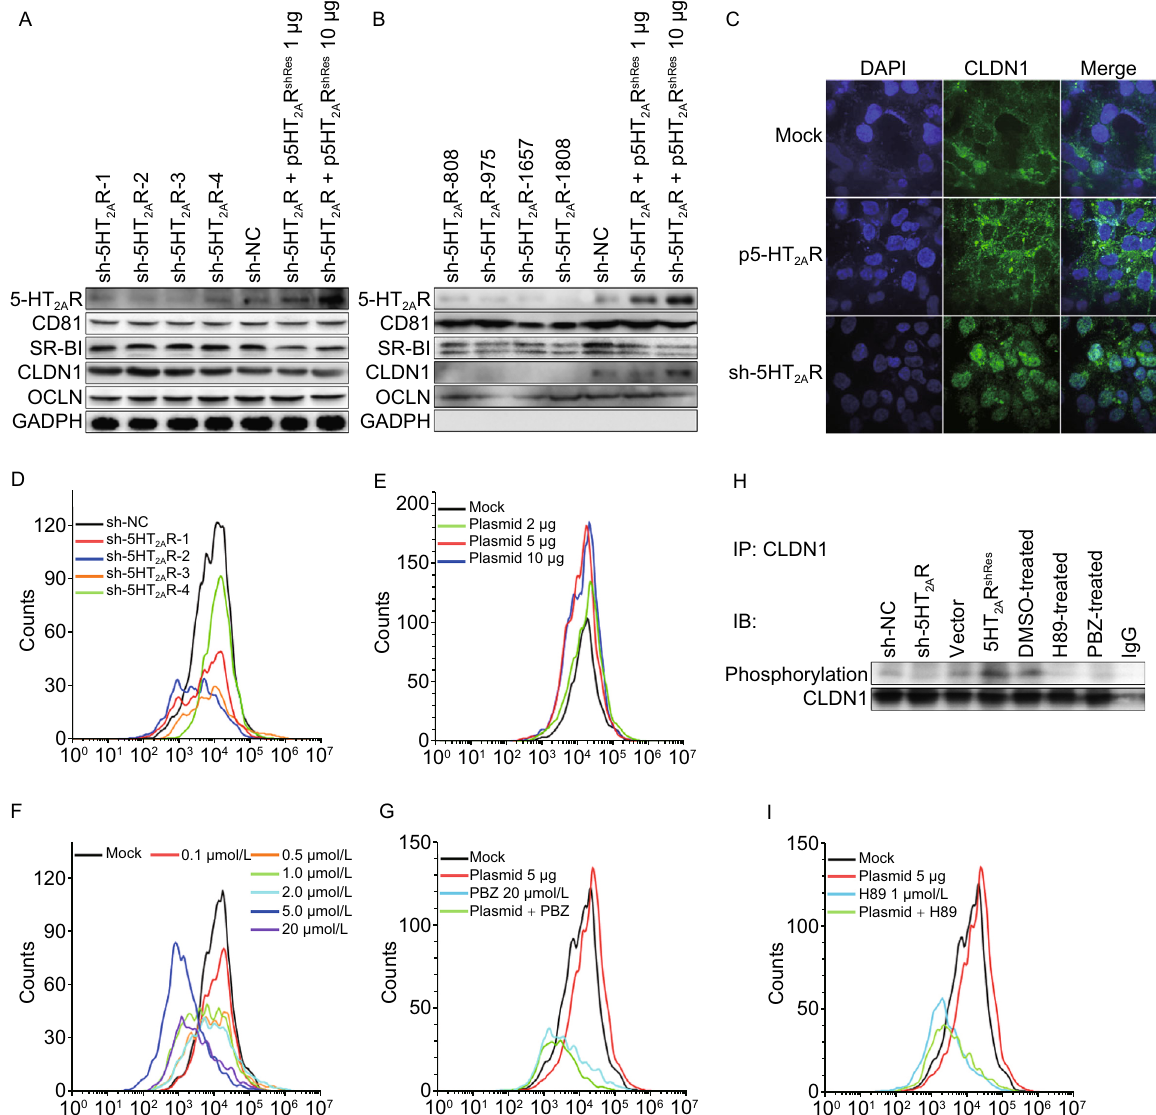
Figure 4. 5-HT 2A R plays a role in the membrane distribution of CLDN1. (A) The expression of 5-HT 2A R, CD81, SR-BI, CLDN1 and OCLN in Huh7.5.1 whole cells containing sh-NC, sh-5HT 2A Rs and 5-HT 2A R overexpression plasmids with indicated amounts. The expression of GAPDH is shown as an internal control. (B) The plasma membranes of Huh7.5.1 cells containing sh-NC, sh- 5HT 2A Rs and 5-HT 2A R overexpression plasmid were separated and the protein amounts of 5-HT 2A R, CD81, SR-BI, CLDN1 and OCLN on the plasma membrane were analyzed by Western blot. (C) Cellular distribution of CLDN1 in the 5-HT 2A R-silenced or overexpressed Huh7.5.1 cells. The localization of endogenous CLDN1 in Huh7.5.1 cells transfected with either an empty vector or 5HT 2A R, or 5HT 2A R-silenced cells was observed using confocal microscopy. CLDN1 expressions on the cell membrane in 5-HT 2A R- silenced cells (D) or 5-HT 2A R-overexpression cells (E) were assessed by fl ow cytometry. The situation of CLDN1 positioning on the membrane were plotted, during treatment with PBZ under various concentration (F) or either PBZ (20 μ mol/L) (G) or H89 (1 μ mol/L) (I) in 5-HT 2A R-overexpression cells. (H) Exogenous CLDN1 was immunoprecipitated by CLDN1 antibody from indicated cell lysates, and immunoblotted with phosphorylation-Ser/Thr antibodies. The data presented are representative of three independent